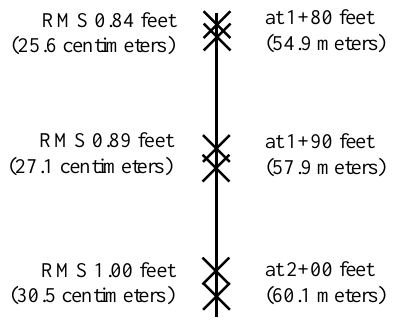
Figure 2. Visual representation of points after